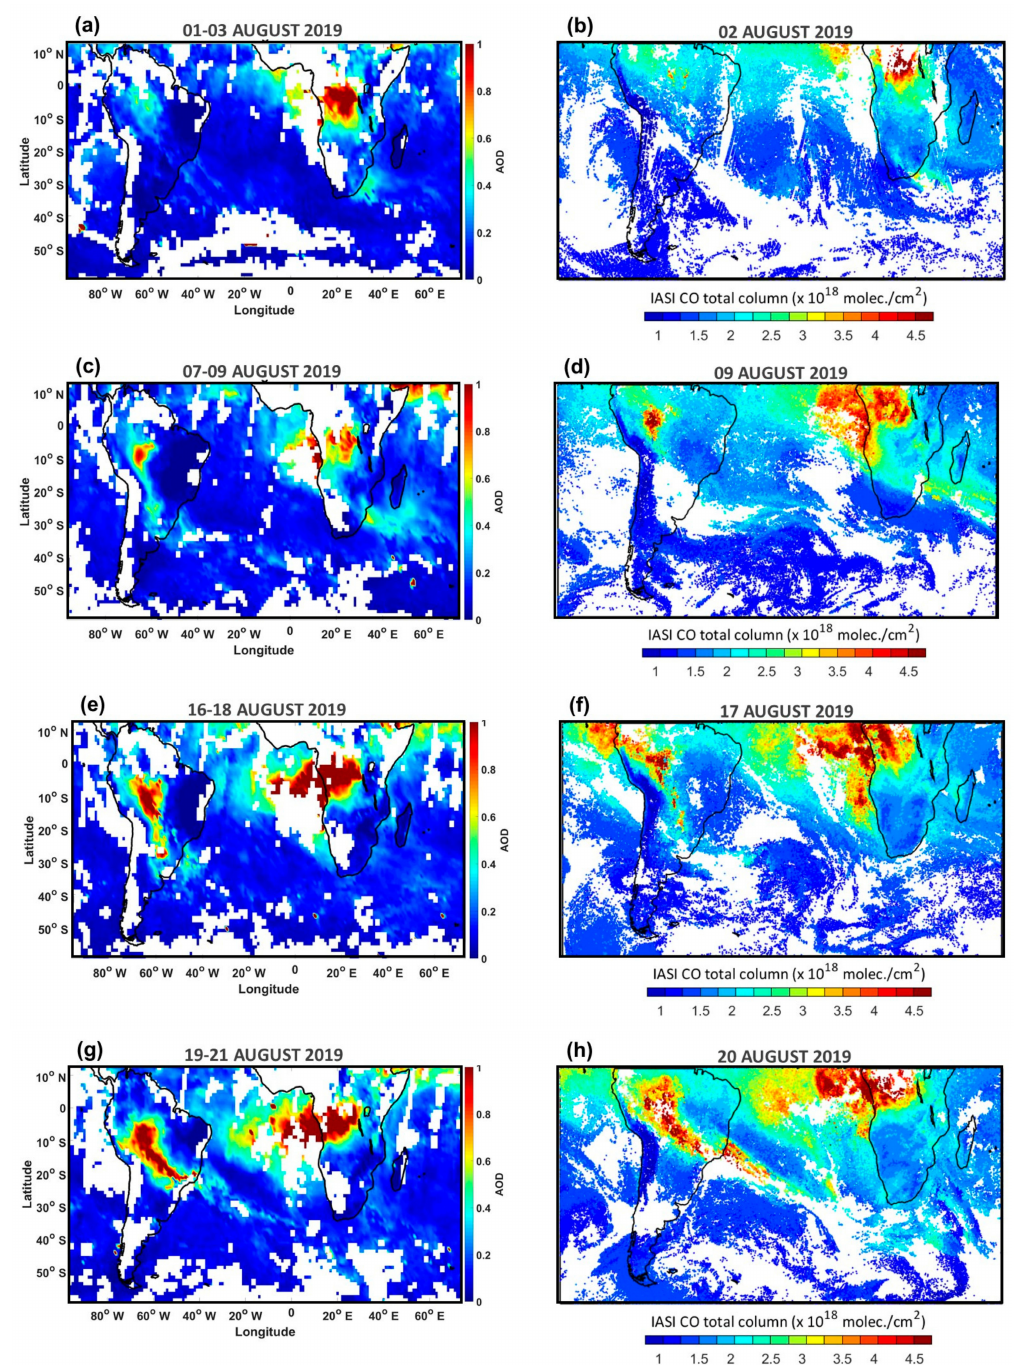
Figure 3. AOD at 550 nm ( on left panels ) and CO total columns ( on right panels ) from MODIS and IASI observations for the same selected dates (2, 9, 17 and 20 August 2019). MODIS AOD values are obtained by averaging observations from 3 consecutive